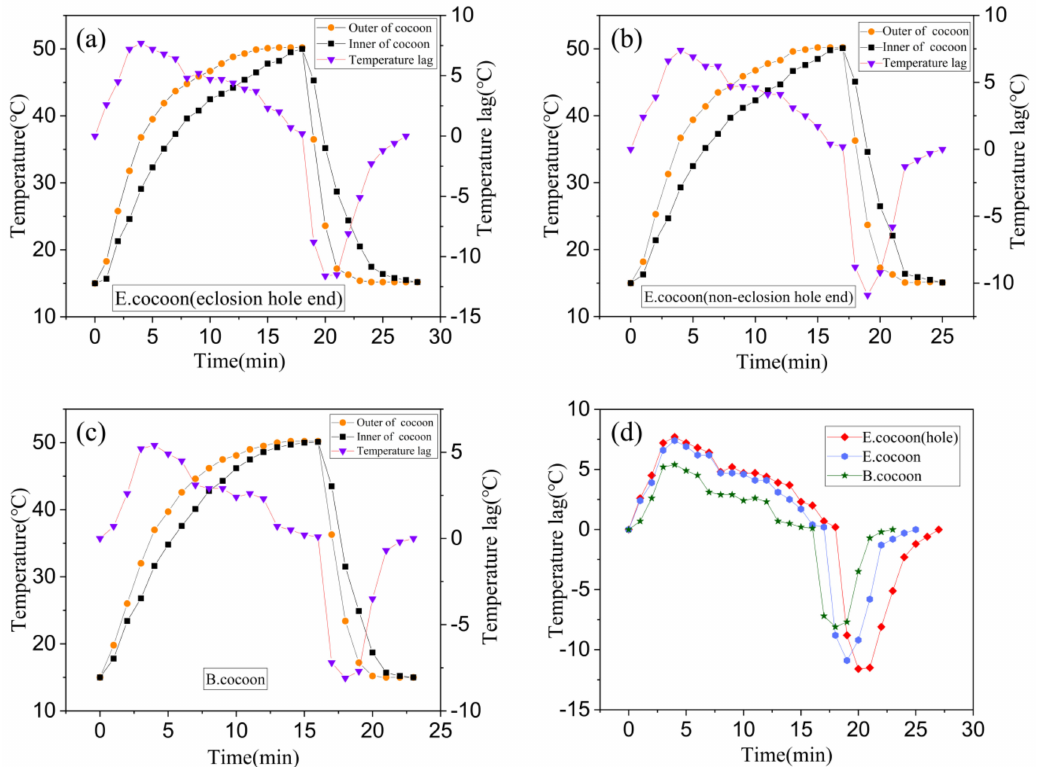
Figure 11. Temperature variation and temperature lag curves for locations both inside and outside the E and B cocoons. ( a ) The temperature probe was inserted into the cocoon from the eclosion hole of the E cocoon for testing; ( b ) the temperature probe was inserted into the cocoon from the noneclosion hole of the E cocoon for testing; ( c ) the temperature probe was inserted into the B cocoon for testing; ( d ) the temperature lag comparison